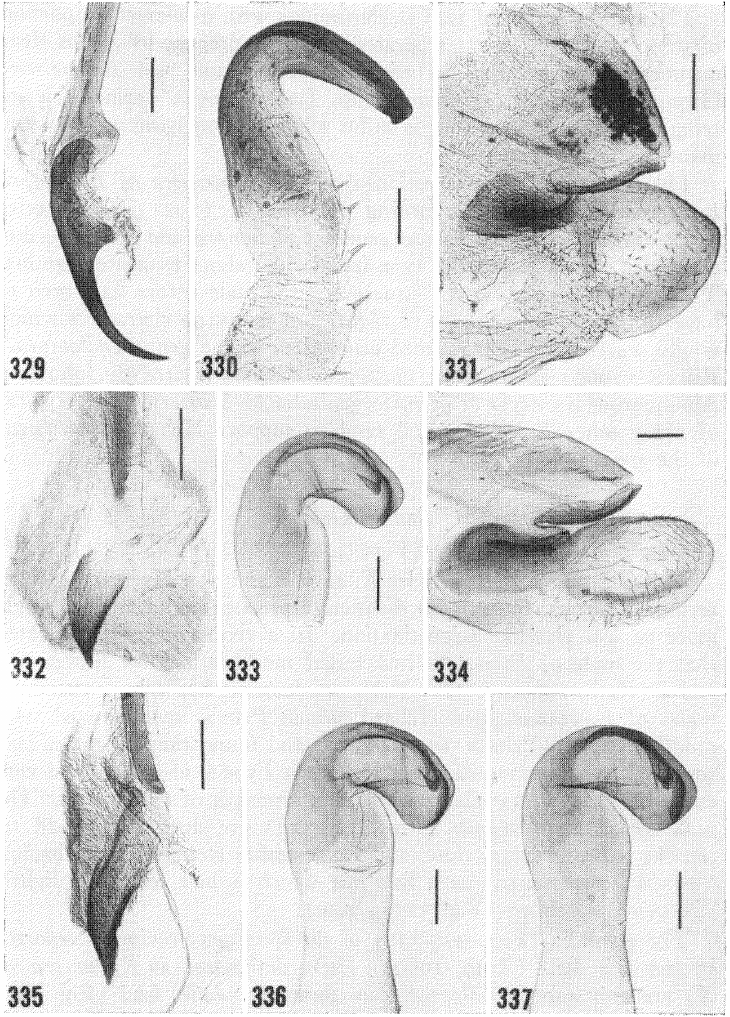
Figs. 329-337. Cockroach male genitalia. 329-331. (182 USNM). Epi- lampra sp. A. Tapurueuara, Rio Negro, Brazil. 332-337. Epilampra sp. C. 332-334. (152 USNM). Camp Rangel, Arague, Venezuela. 335-336. (55 USNM). Same data as Figs. 332-334. 337. (112 USNM). Ar. Rancho Grande, Venezuela. (scale 0.2